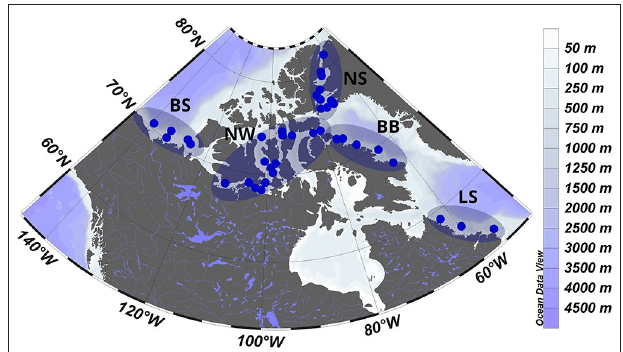
FIGURE 1 | Locations of the sampling stations in different oceanographic regions [Beaufort Sea (BS), Northwest Passage (NW), Nares Strait (NS), Baffin Bay (BB), and Labrador Sea (LS)] of the Canadian Arctic from 29 July to 2 October